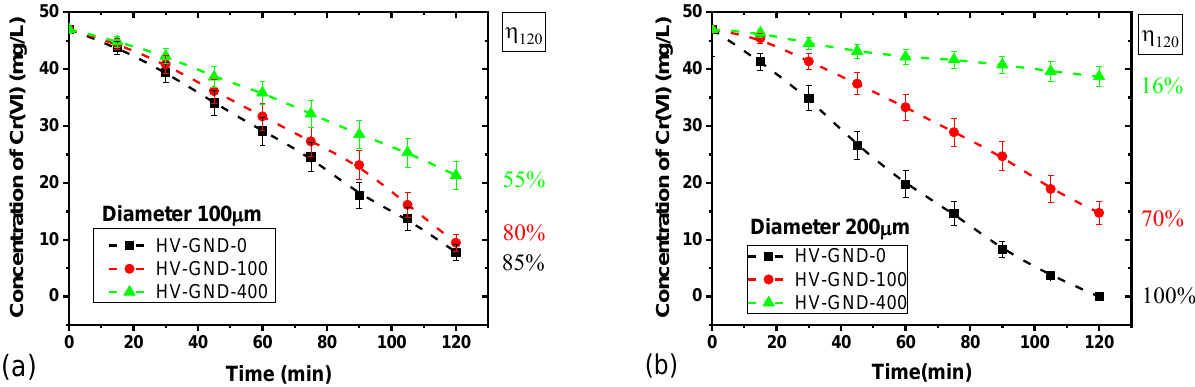
Figure 5. Concentration of Cr(VI) as a function of time for different electrode lengths (0, 100, 400 µ m) and for two diameters: ( a ) Ø = 100 µ m and ( b ) Ø = 200 µ m obtained during for pin-to-pin discharges in Cr(VI) solution (47 mg/L, σ = 4 mS/cm, pH = 2.3), V = 100 mL, U = 9 kV, f = 50 Hz, ∆ t = 500 µ s, gap = 2 mm. η 120 refers to the reduction efficiency after 120 min of PLI